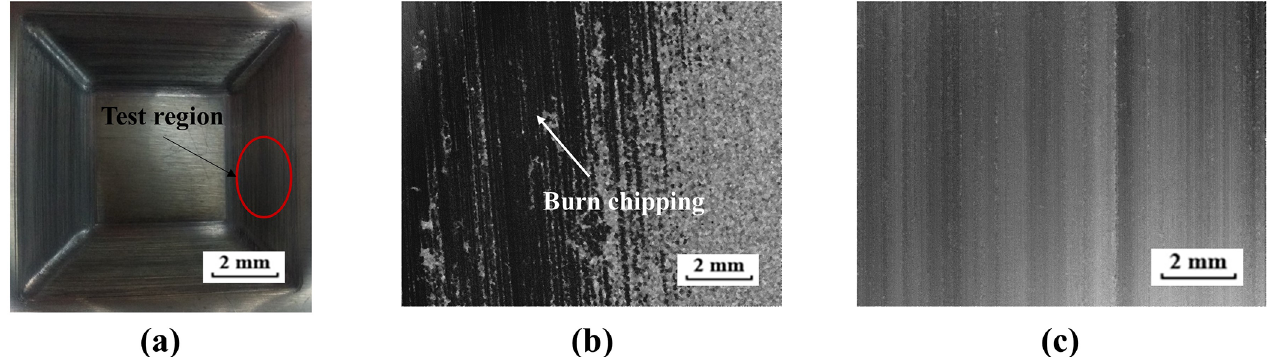
Fig. 9. The pro fi le and surface topography of forming part: (a) test region and (b) effect before improvement and (c) effect after